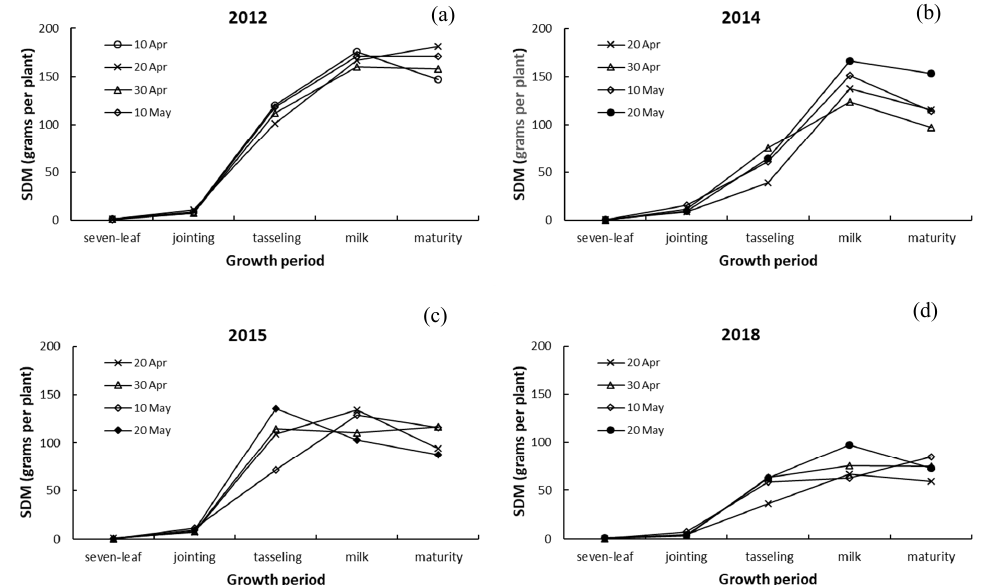
Figure 6. SDMs at different growth stages of maize sown on different dates: ( a ) 2012, ( b ) 2014, ( c ) 2015, ( d ) 2018.